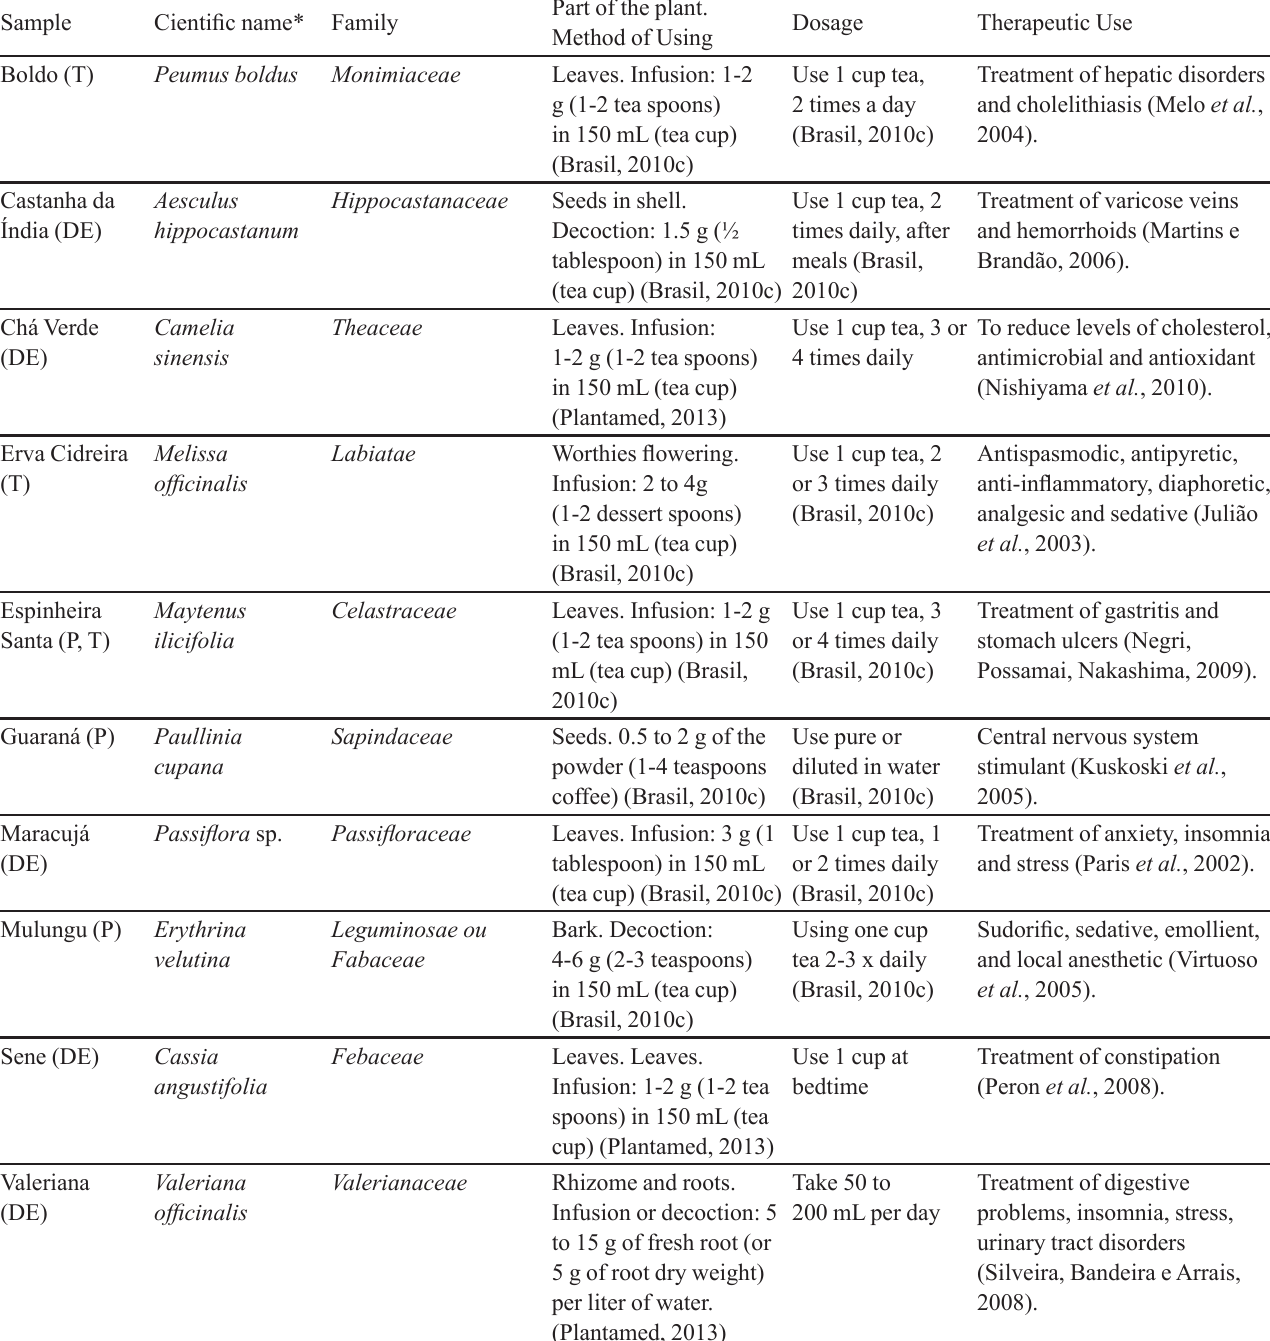
TABLE I - Samples evaluated and respective characteristic